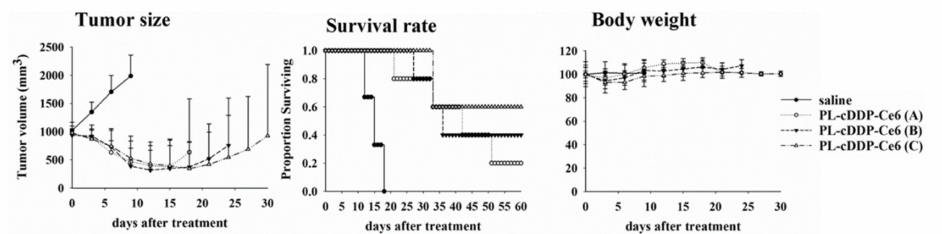
Figure 5. Therapeutical outcomes of PL-cDDP-Ce6 on nude mice bearing S462-TY xenograft tumor with average tumor size of 1000 mm 3 . A single dose of saline or PL-cDDP-Ce6 was injected into the tail vein of mice in each group (N = 5). The Ce6 dose administrated in mice was 1. 5 mg / kg and the cDDP dose varied, 1.43 mg / kg (A), 2.54 mg / kg (B), and 4.07 mg / kg (C). After drug injection, light irradiation (100 J / cm 2 ) was applied onto the tumor at 2 h and 12 h, respectively. Left panel, tumor size; Middle panel, survival rate; Right panel, body weight. Data are presented as mean ± S.D. for each